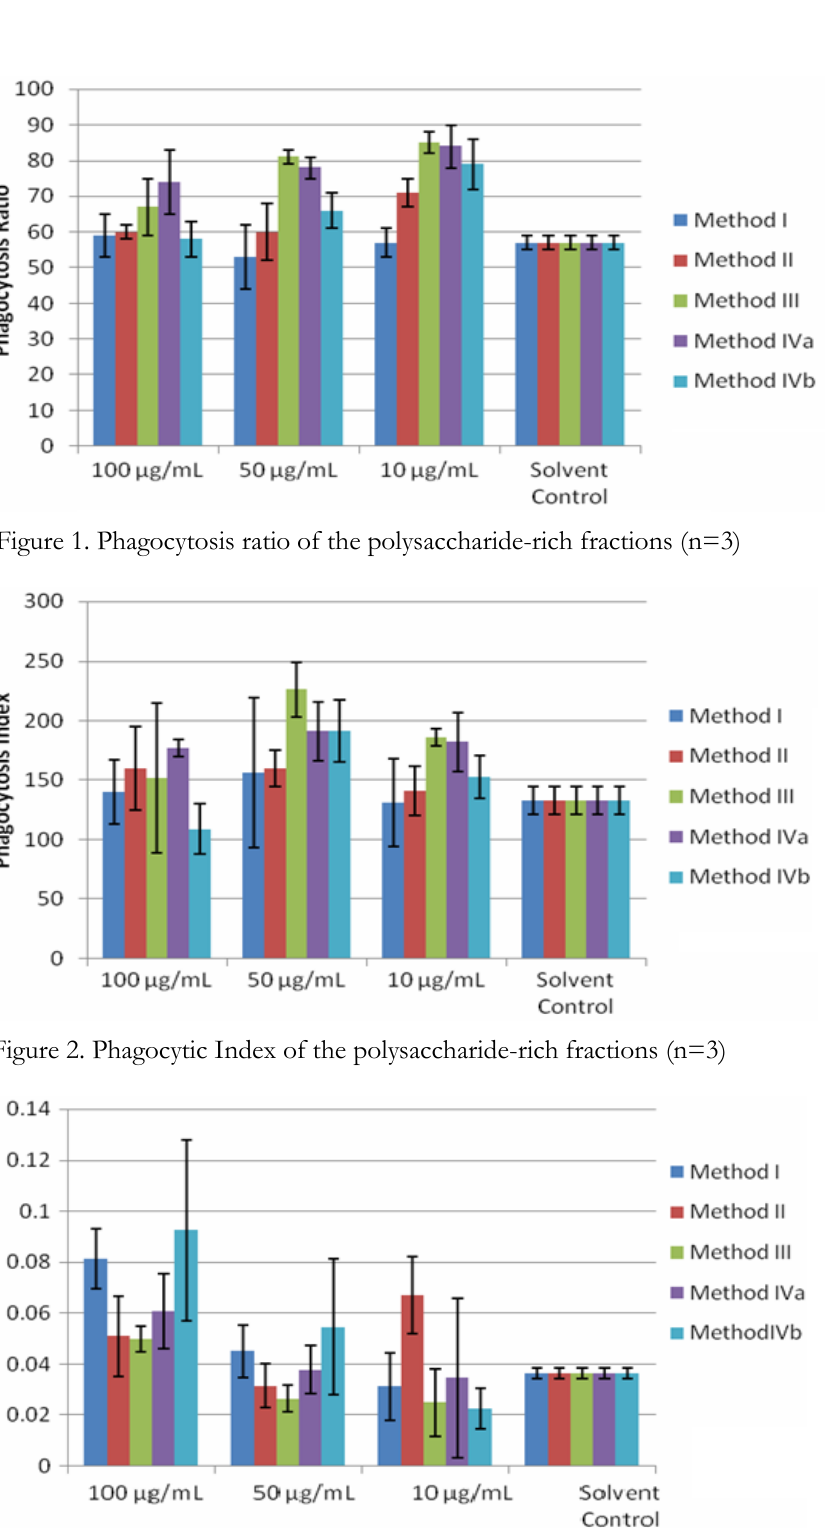
Figure 3. Optical density the lymphocyte cells suspension in the present of the polysaccharide-rich fractions